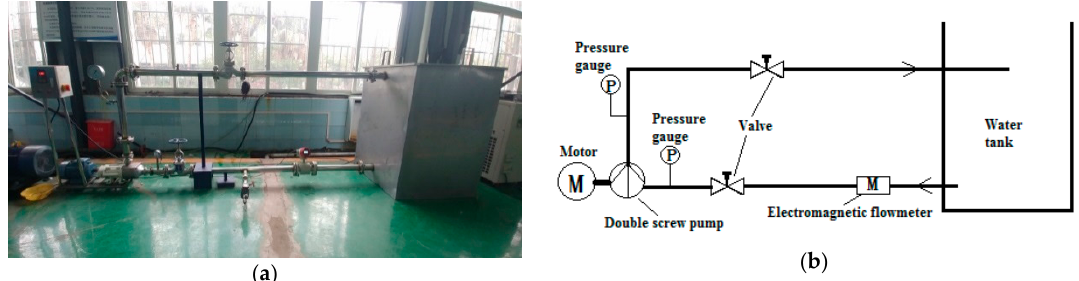
Figure 5. Double screw pump test loop. ( a ) Real test loop; ( b ) Schematic diagram.